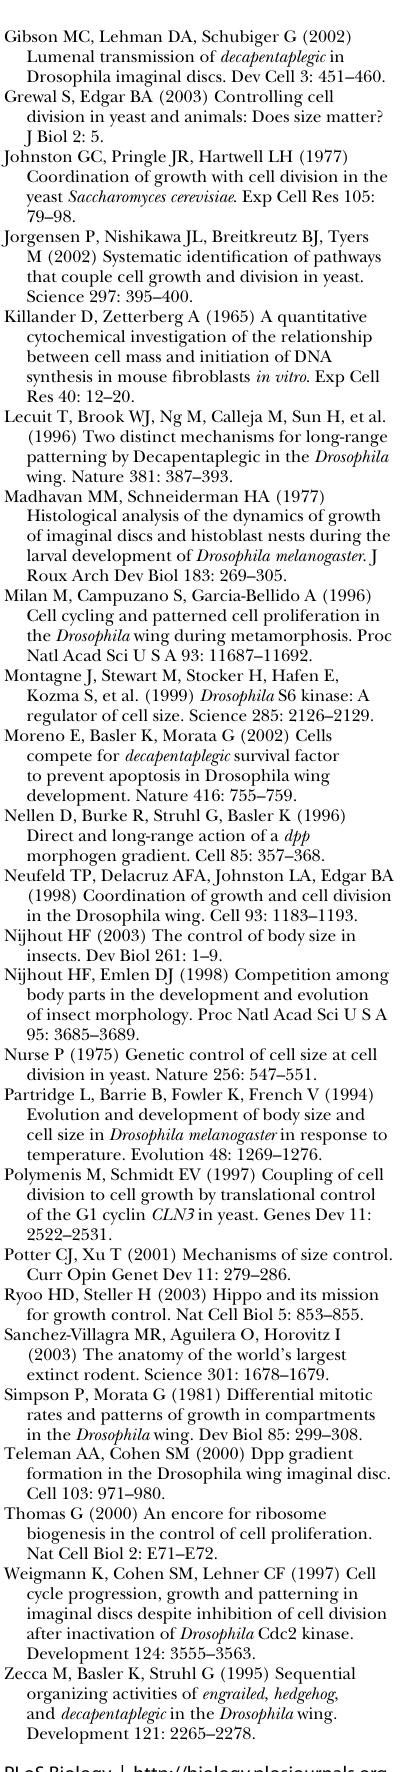
Volume 1 | Issue 3 | Page 323 PLoS Biology |